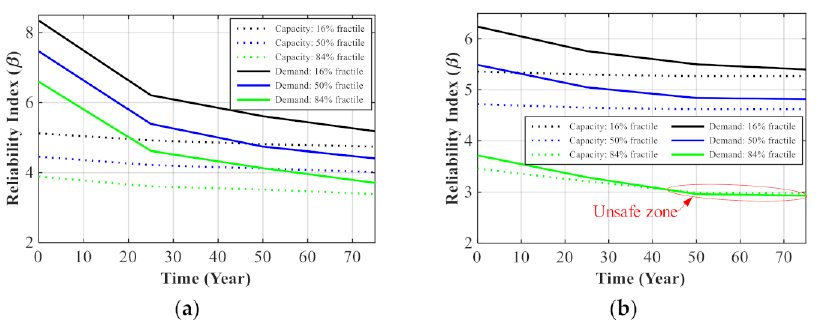
Figure 21. Degradation of reliability index with time for two damage level; ( a ) serviceability, ( b )